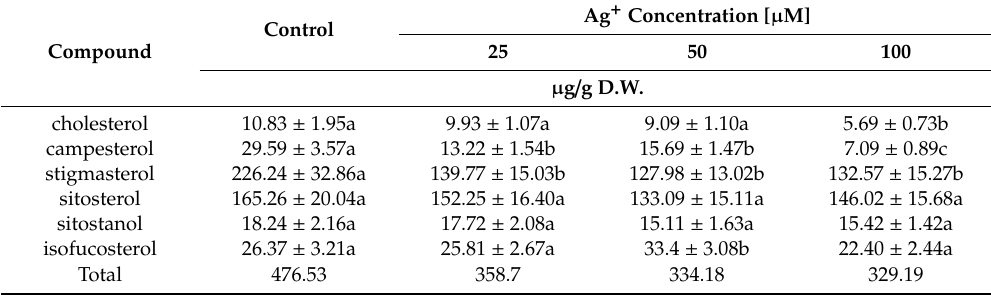
Table 3. The content of sterols in line CH2 hairy root tissue after treatment with Ag + ions.